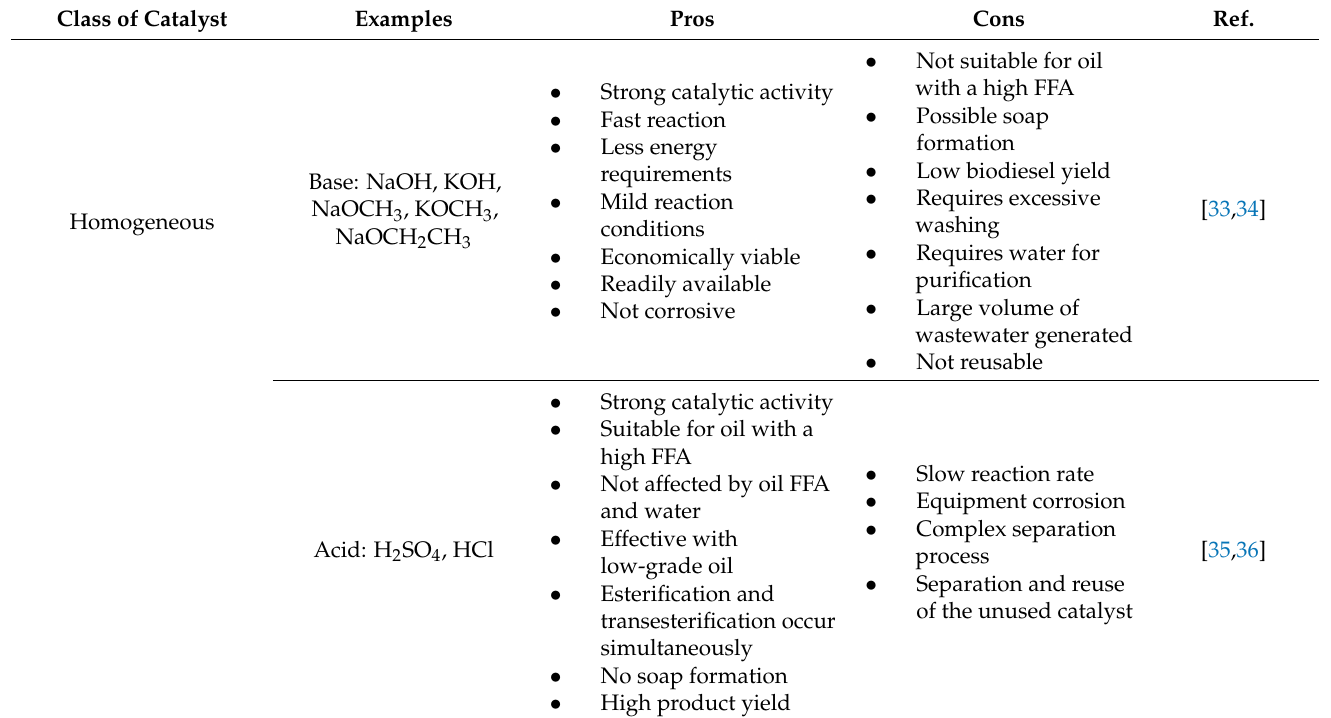
Table 3. Examples, pros, and cons of classes of catalysts for the transesterification process. Class of Catalyst